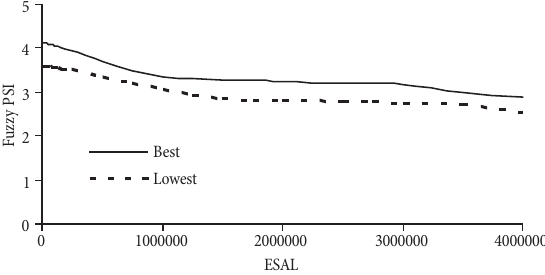
Fig. 11. Relationship of ESAL with FPSI of various materials